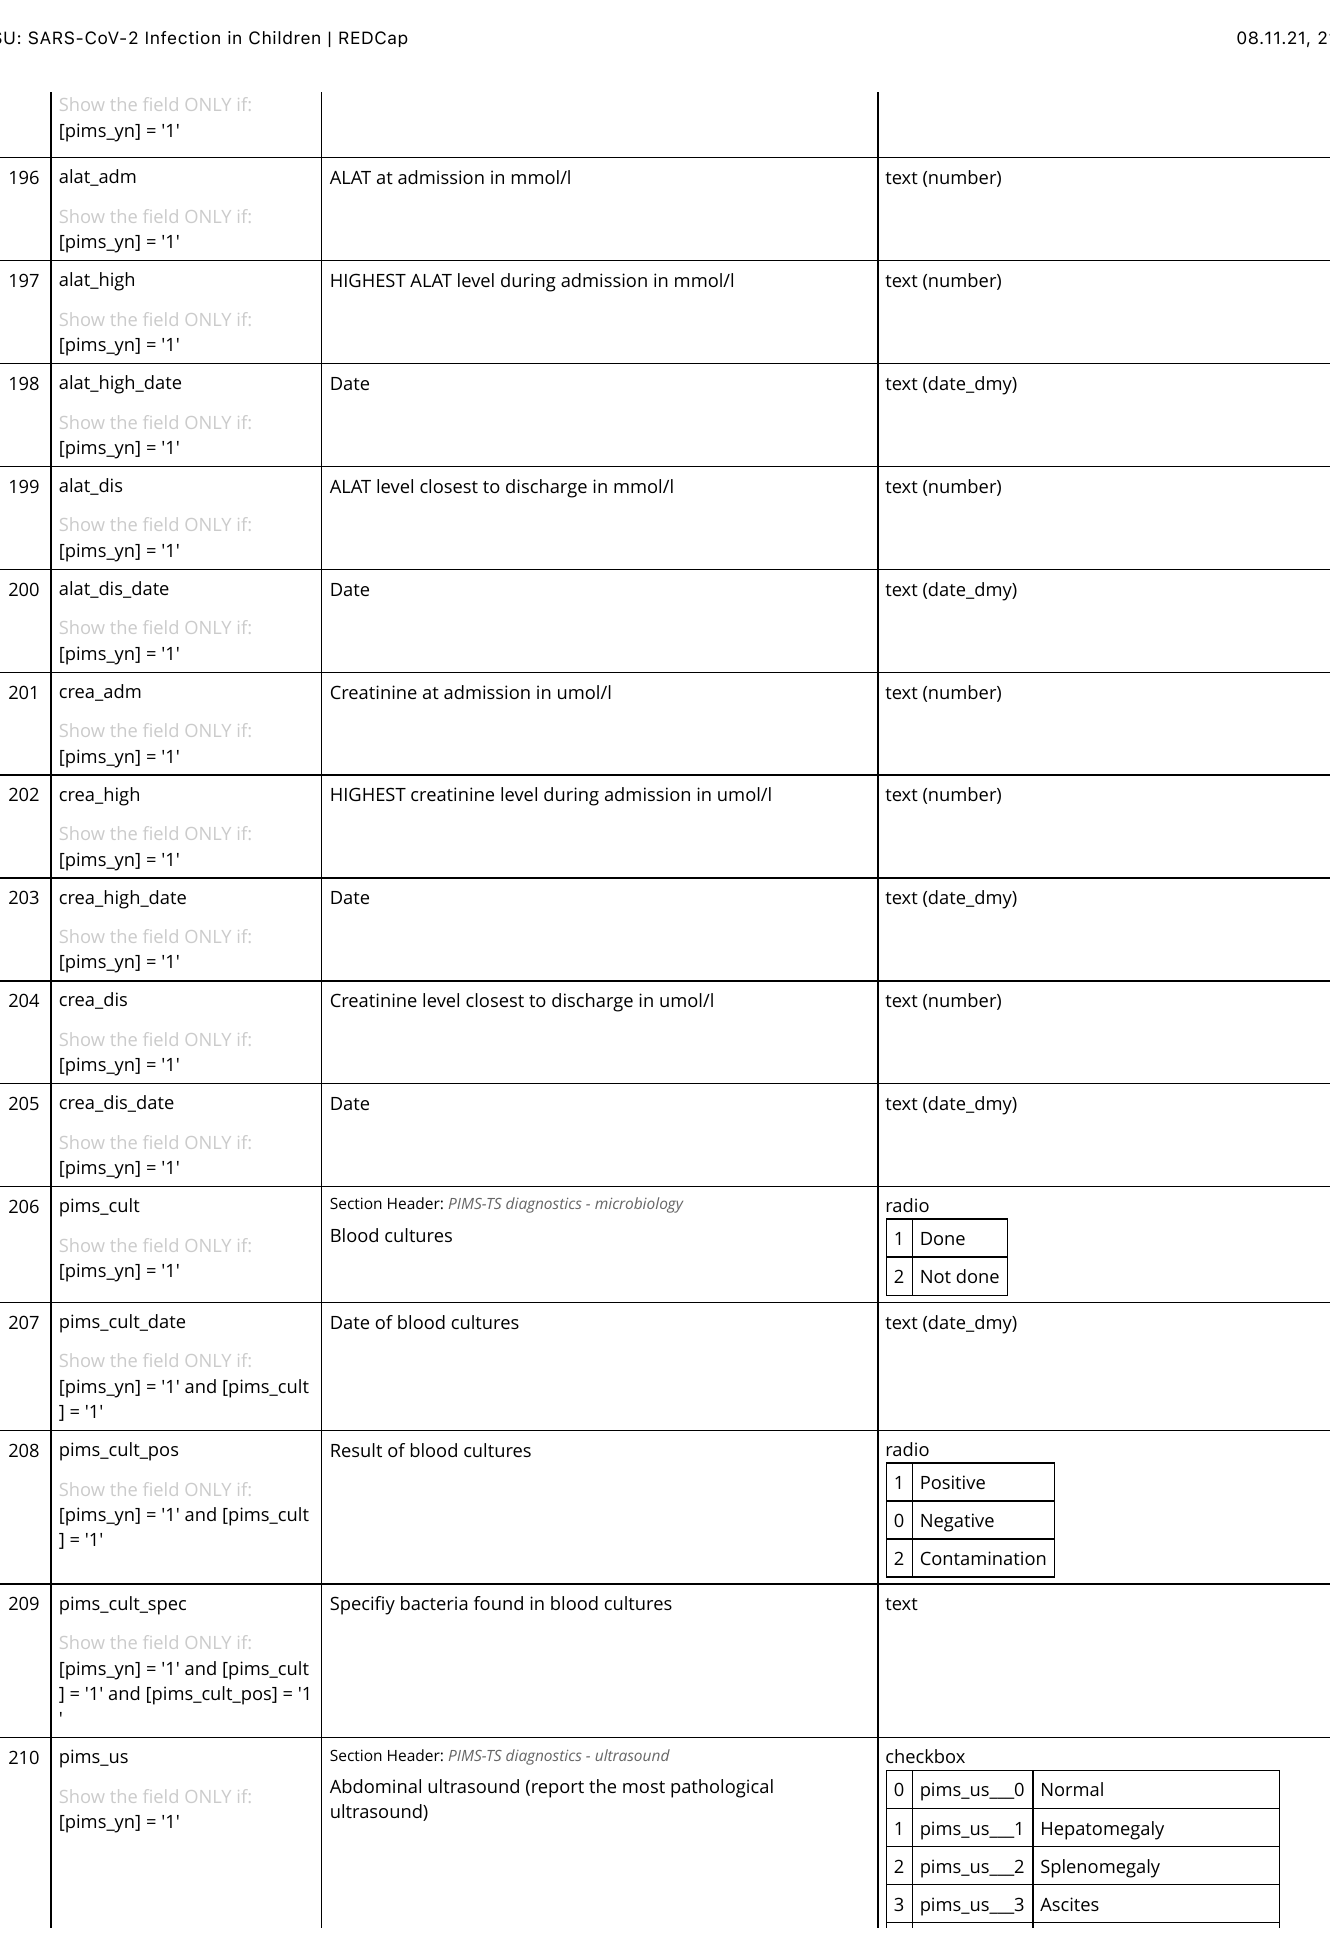
Section Header: PIMS-TS diagnostics - ultrasound Abdominal ultrasound (report the most pathological ultrasound)